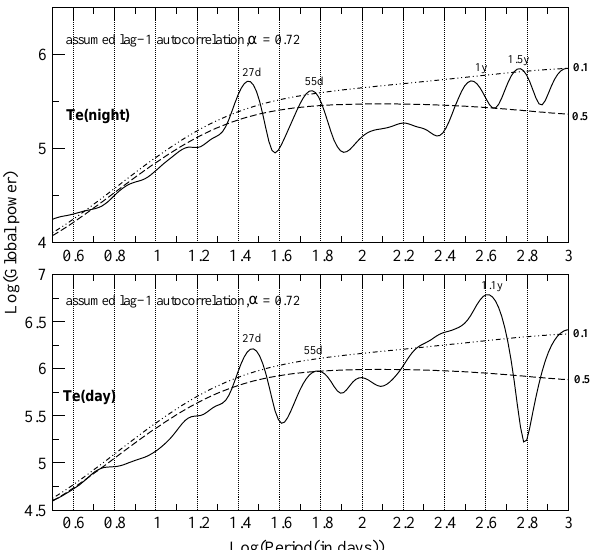
Fig. 7. Global wavelet spectra of average values of electron tem- perature during daytime and that of nighttime. The dotted line in- dicates the 90% confidence level and the dashed line indicates the 50% confidence level of the red noise background